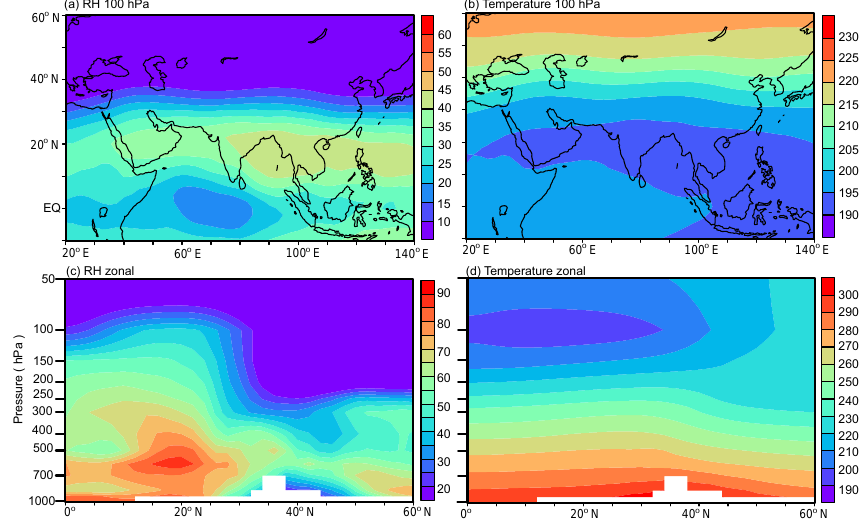
Figure 13. (a, b) Distributions of RH (%) and temperature (K) at 100hPa. (c, d) The latitude–altitude cross sections of RH (%) and temper- ature (K) averaged over 70–105 ◦ E. RH and temperature are from the GEOS5 assimilated meteorological fields, and all the values are the averages over June–August of year 2005.